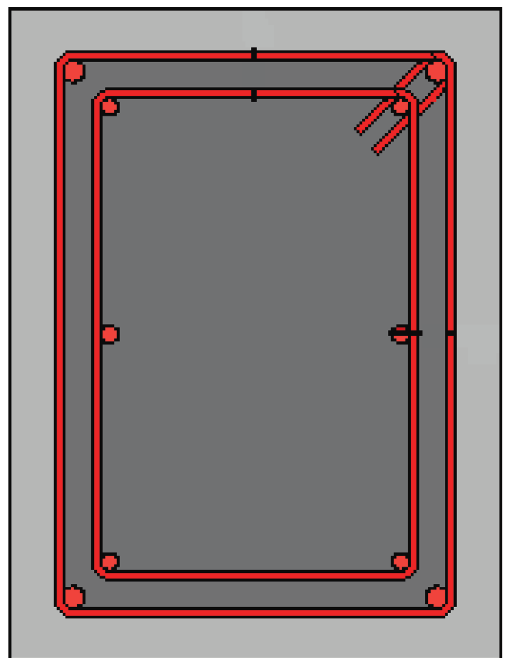
Figure 14: RC jacketed